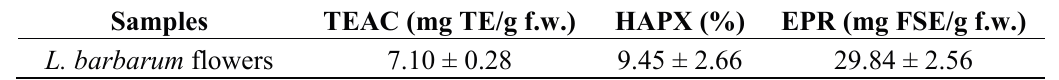
Table 3. Antioxidant capacity parameters. TEAC, Trolox equivalent antioxidant capacity; HAPX, hemoglobin ascorbate peroxidase activity